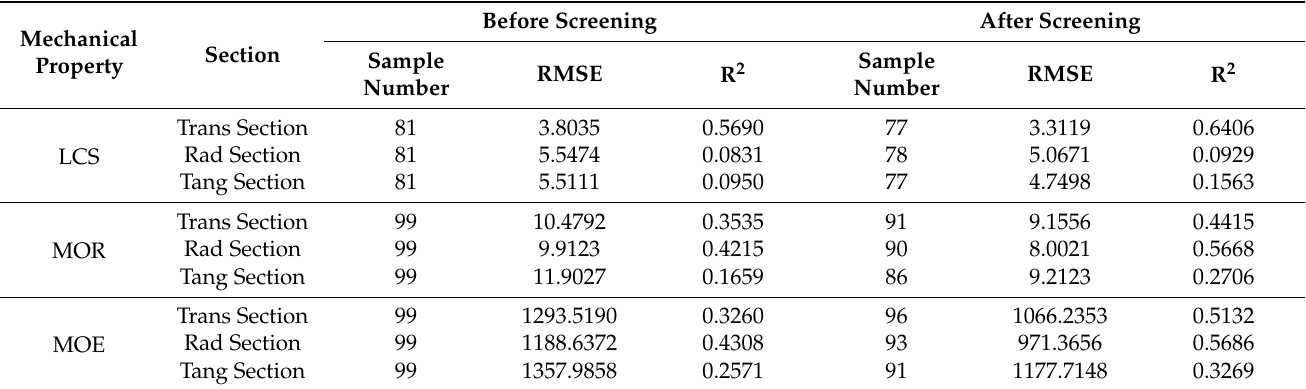
Figure 4. PRESS distributions of MCCV of different sections of Larix gmelinii . ( A ) LCS of transverse section, ( B ) LCS of radial section, ( C ) LCS of tangential section, ( D ) MOR of transverse section, ( E ) MOR of radial section, ( F ) MOR of tangential section, ( G ) MOE of transverse section, ( H ) MOE of radial section, ( I ) MOE of tangential section. Table 1. MCCV screening of wood mechanical